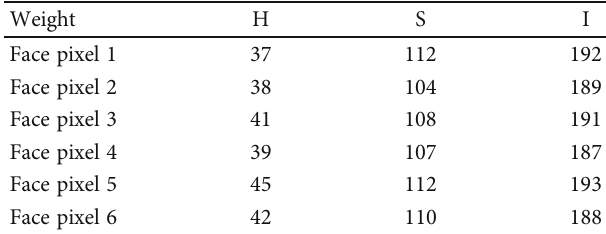
Table 1: Values of some students ’ face pixels in HSI